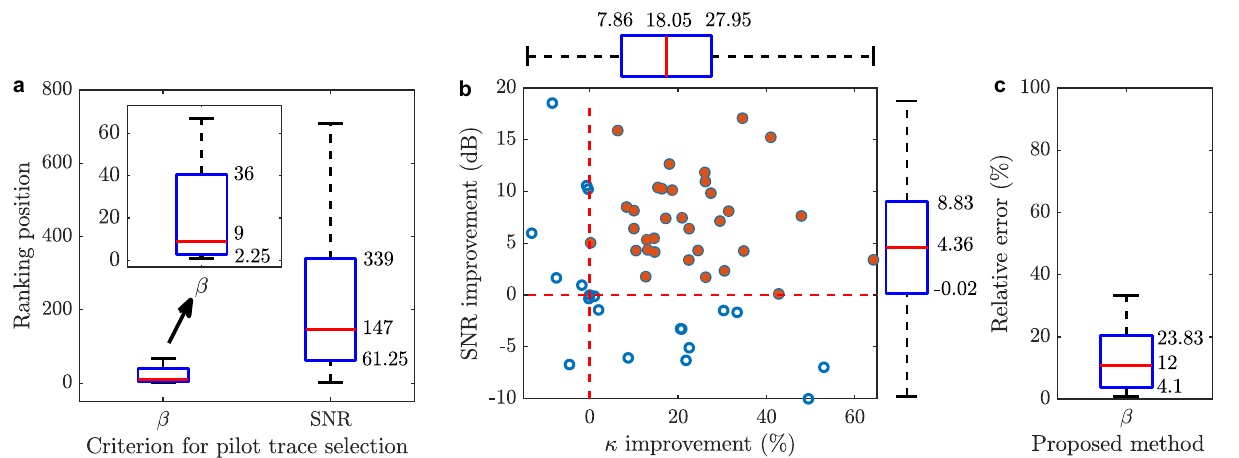
Fig. 9 Statistical results. a Ranking of the pilot traces selected over 50 datasets with different source locations using the proposed blind RMS reliability indicator β and the channel with the best SNR. The boxplots in the fi gure indicate the 25th, 50th and 75th percentile of the ranking position distribution. For the sake of visualisation, the inset shows a zoom-in of the results based on the blind RMS reliability indicator β . b SNR enhancement and improvement of the similarity indicator κ for the 50 analysed cases. c Relative error of the proposed blind source